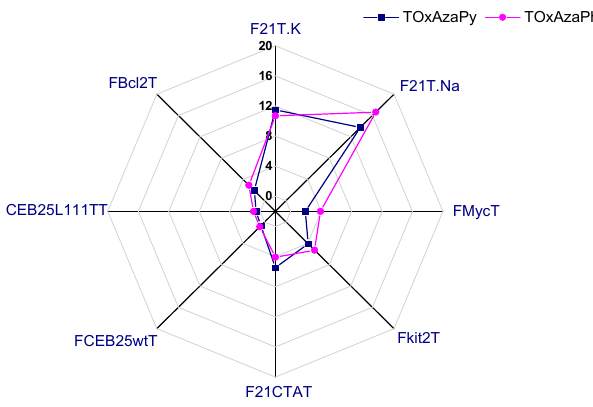
Figure 4. Stabilization of compounds TOxAzaPy and TOxAzaPhen towards several G4 structures. Δ T m values are plotted for each sequence in the buffer conditions mentioned in Table 3.